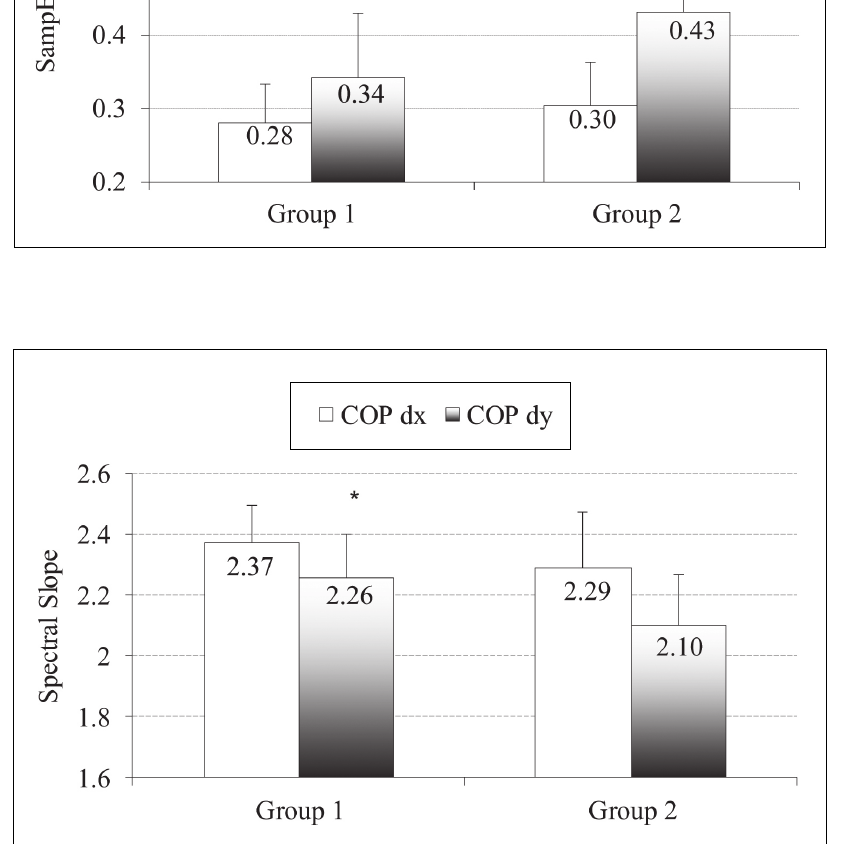
Note. * – p < .05, group 1 compared to group